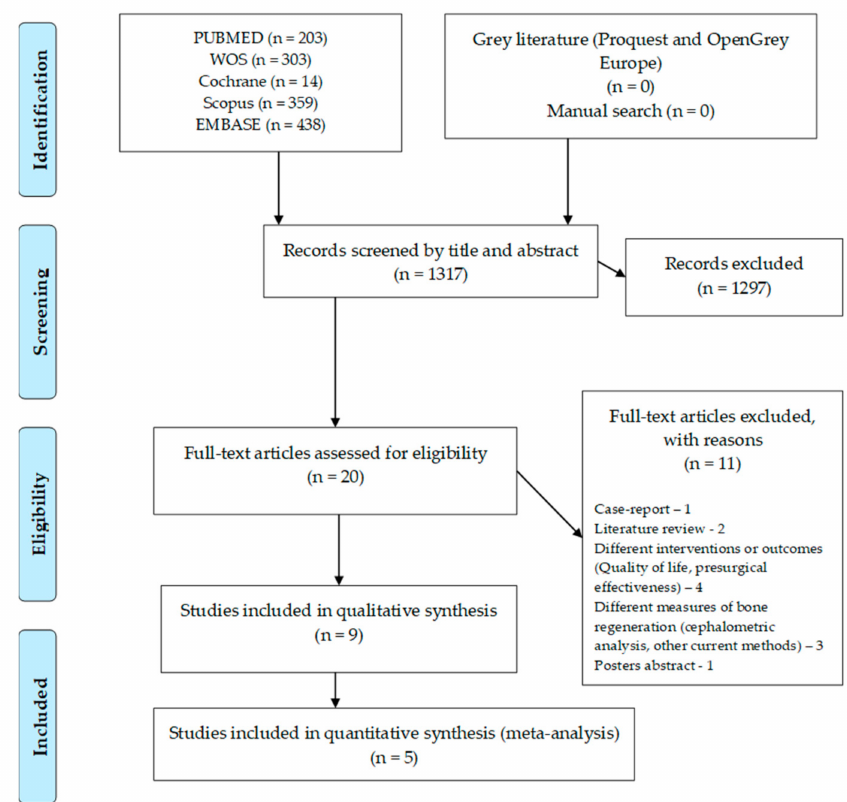
Figure 1. Flow chart for included systematic